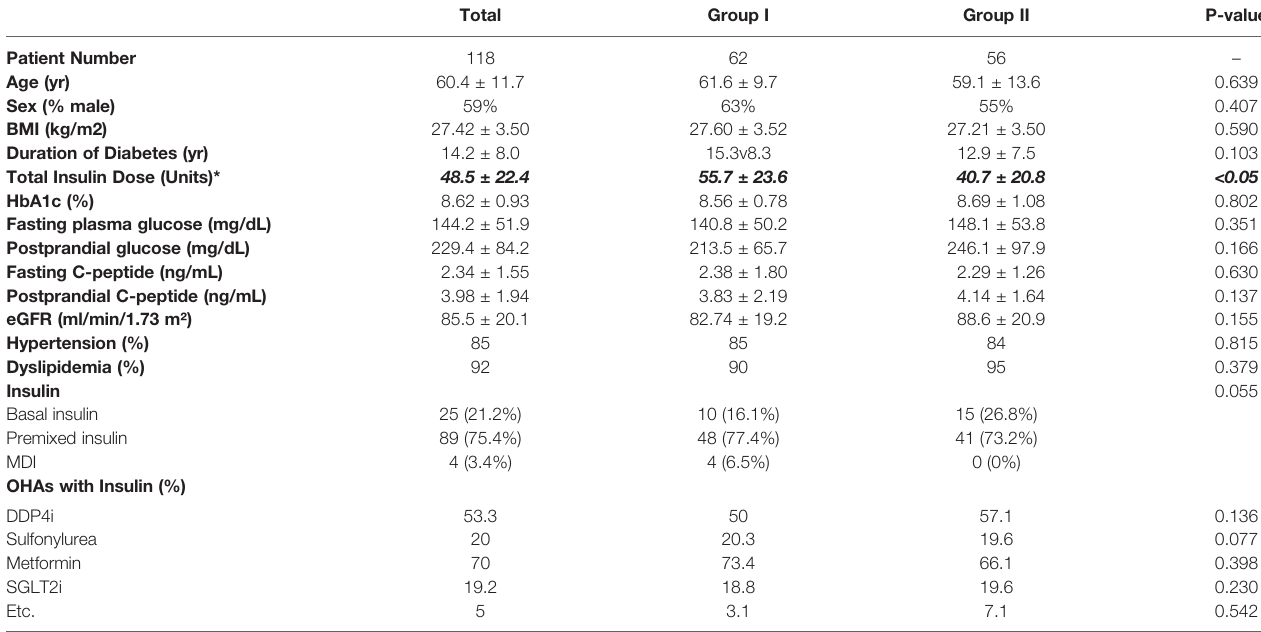
TABLE 1 | Clinical and laboratory characteristics of patients at